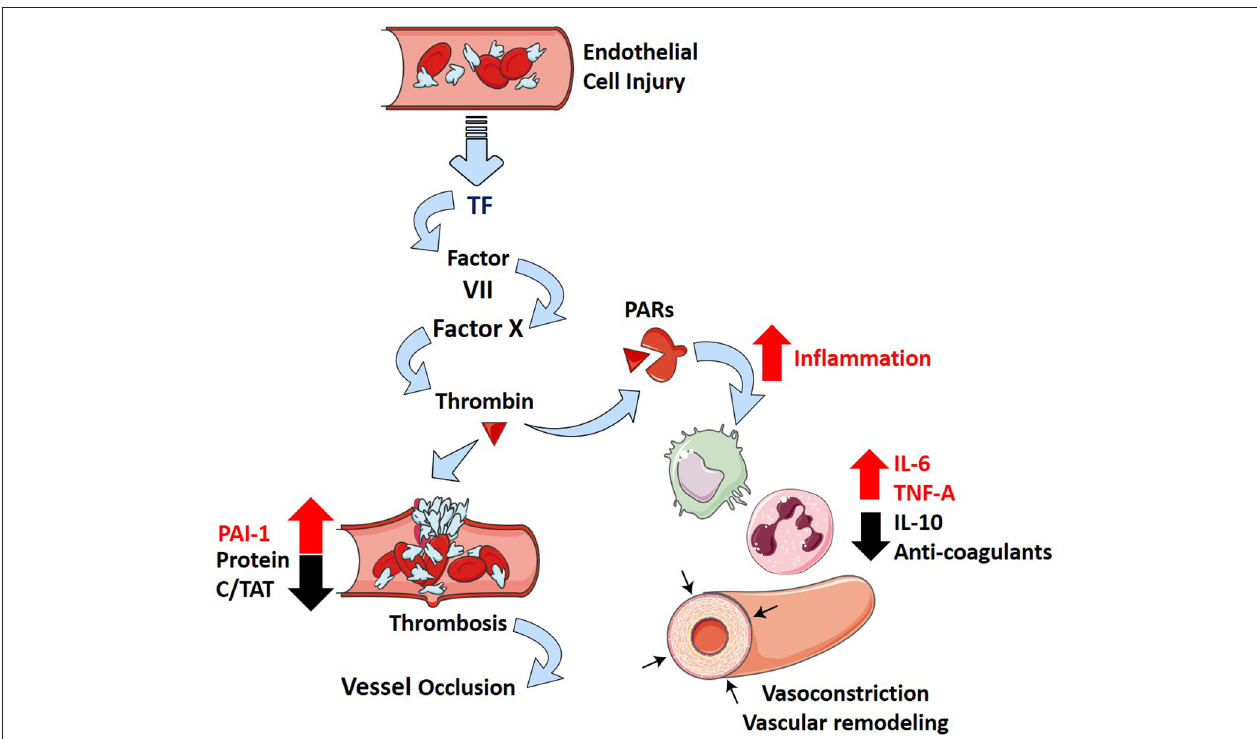
FIGURE 2 | Inflammation and thrombosis in ARDS and how they contribute to PH. Injury to the alveolar-capillary interface in ARDS leads to the release of tissue factor from the endothelial cells and induces coagulation through the extrinsic pathway. The penultimate mediator of coagulation, thrombin (dark red triangle), interacts with proteinase-associated receptors (PARs, dark red receptor) to promote inflammation (increase in IL-6, TNF- α , and IL-10) and suppress several negative regulatory elements of coagulation (decrease in Protein C, thrombin antithrombin complexes—TATs, anticoagulants; increase in plasminogen activator inhibitor 1—PAI-1). This leads to downstream effects of inflammatory cytokines (IL-6 and TNF- α ) that include vascular remodeling and vasoconstriction, which overwhelm the protective effects of anti-inflammatory cytokine IL-10 and further incite thrombosis.